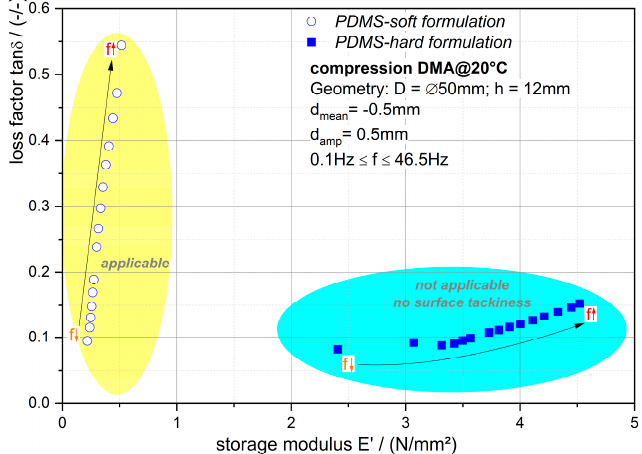
Figure 5. Loss factor tan δ over storage modulus E’ characteristic of the investigated formulation at 20 °C under compression DMA loading procedure .